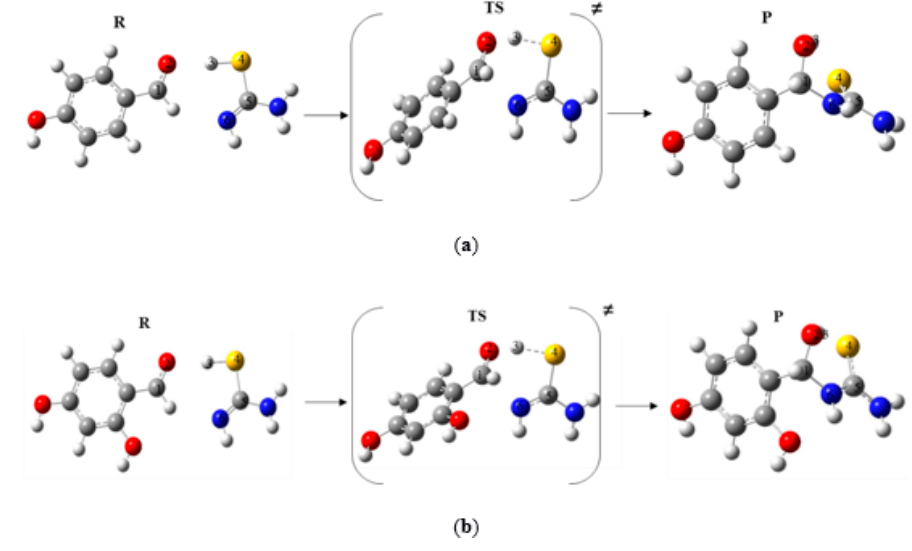
Figure 3. Minimum energy structures for reactant (R), transition state (TS), and products (P), for the second stage of the Biginelli reaction studied at the B3LYP/6-31++G(2d,p) level of theory. ( a ) 4-hydroxybenzaldehyde; ( b ) 2,4-dihydroxybenzaldehyde.